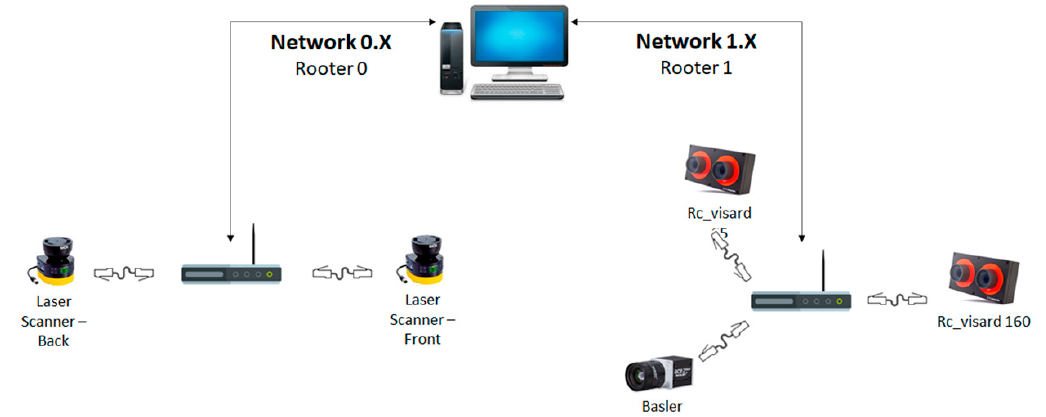
Figure 16. Network topology regarding sensors. Table 4. Frames per second (FPS) of active cameras .